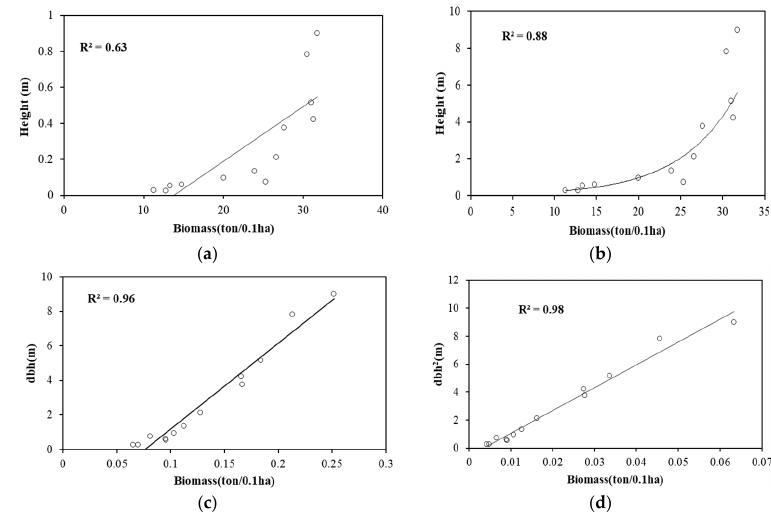
Figure 6. Correlation plots between TLS-derived parameters and biomass. ( a ) Correlation between height and biomass; ( b ) log-transformed correlation between height and biomass; ( c ) correlation between dbh and biomass; and ( d ) correlation between dbh 2 and biomass.